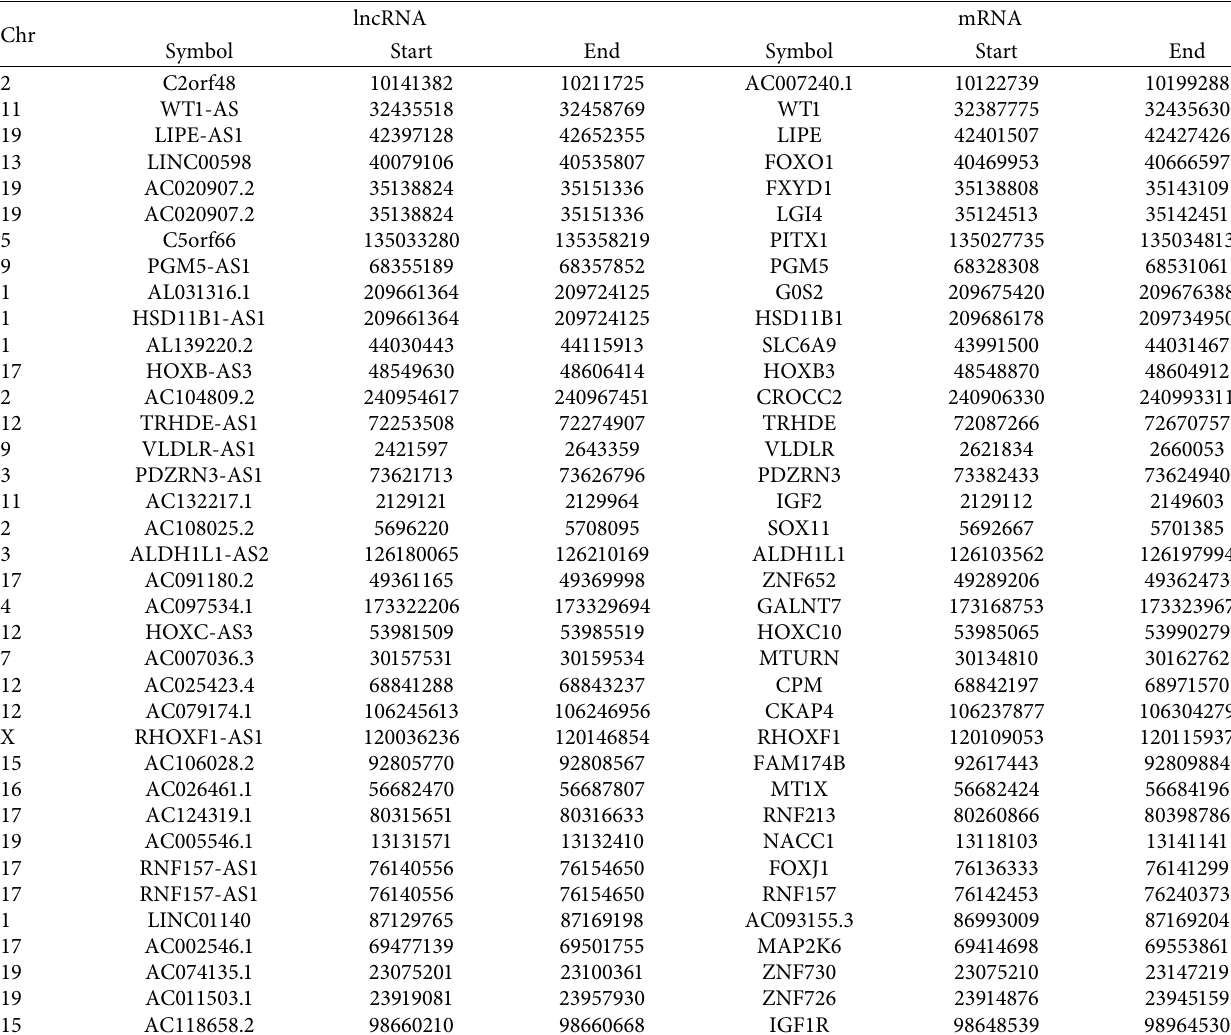
Table 4: DElncRNAs-nearby DEmRNA